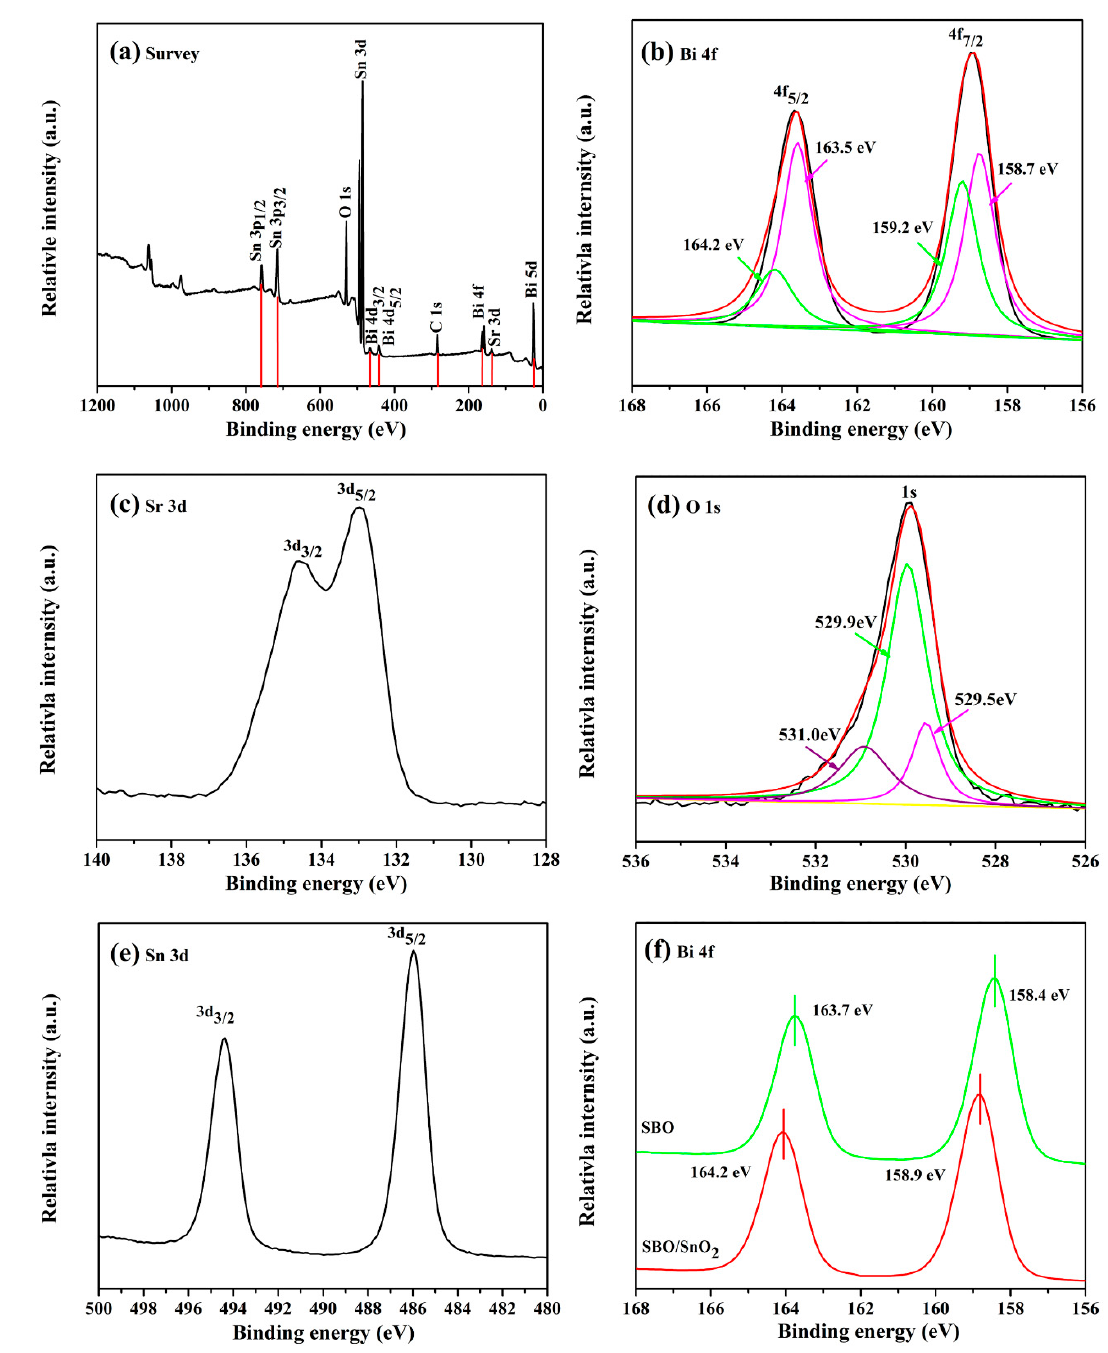
Figure 2. XPS spectra of 14 wt% SBO / SnO 2 composite: ( a ) full scan survey of all elements and high-revolution spectra of ( b ) Bi 4f, ( c ) Sr 3d, ( d ) O 1s, ( e ) Sn 3d, and ( f ) Bi 4f of pure SBO for comparison.